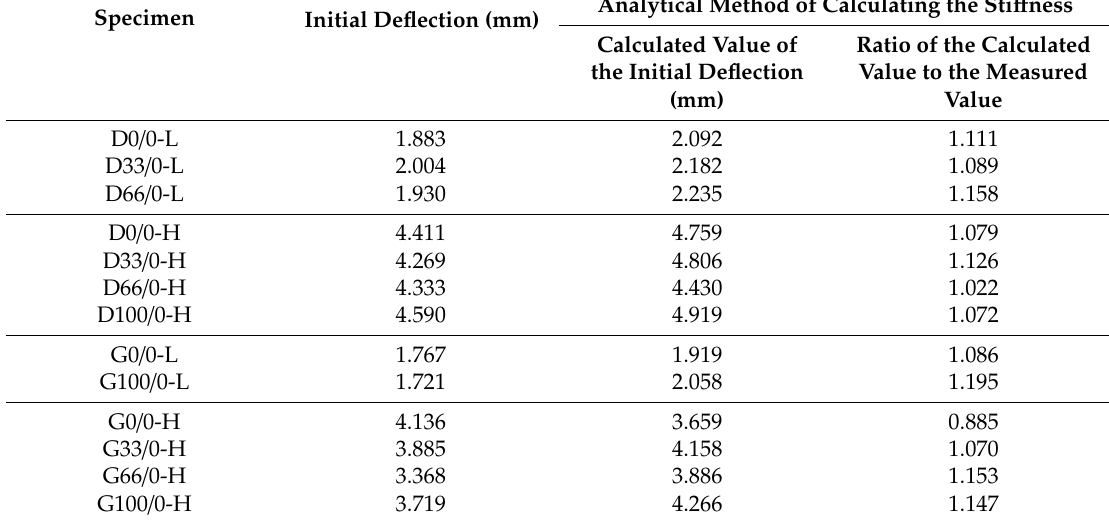
Table 6. Calculated initial deflection of the specimens without RFAs by the analytical method of calculating the sti ff